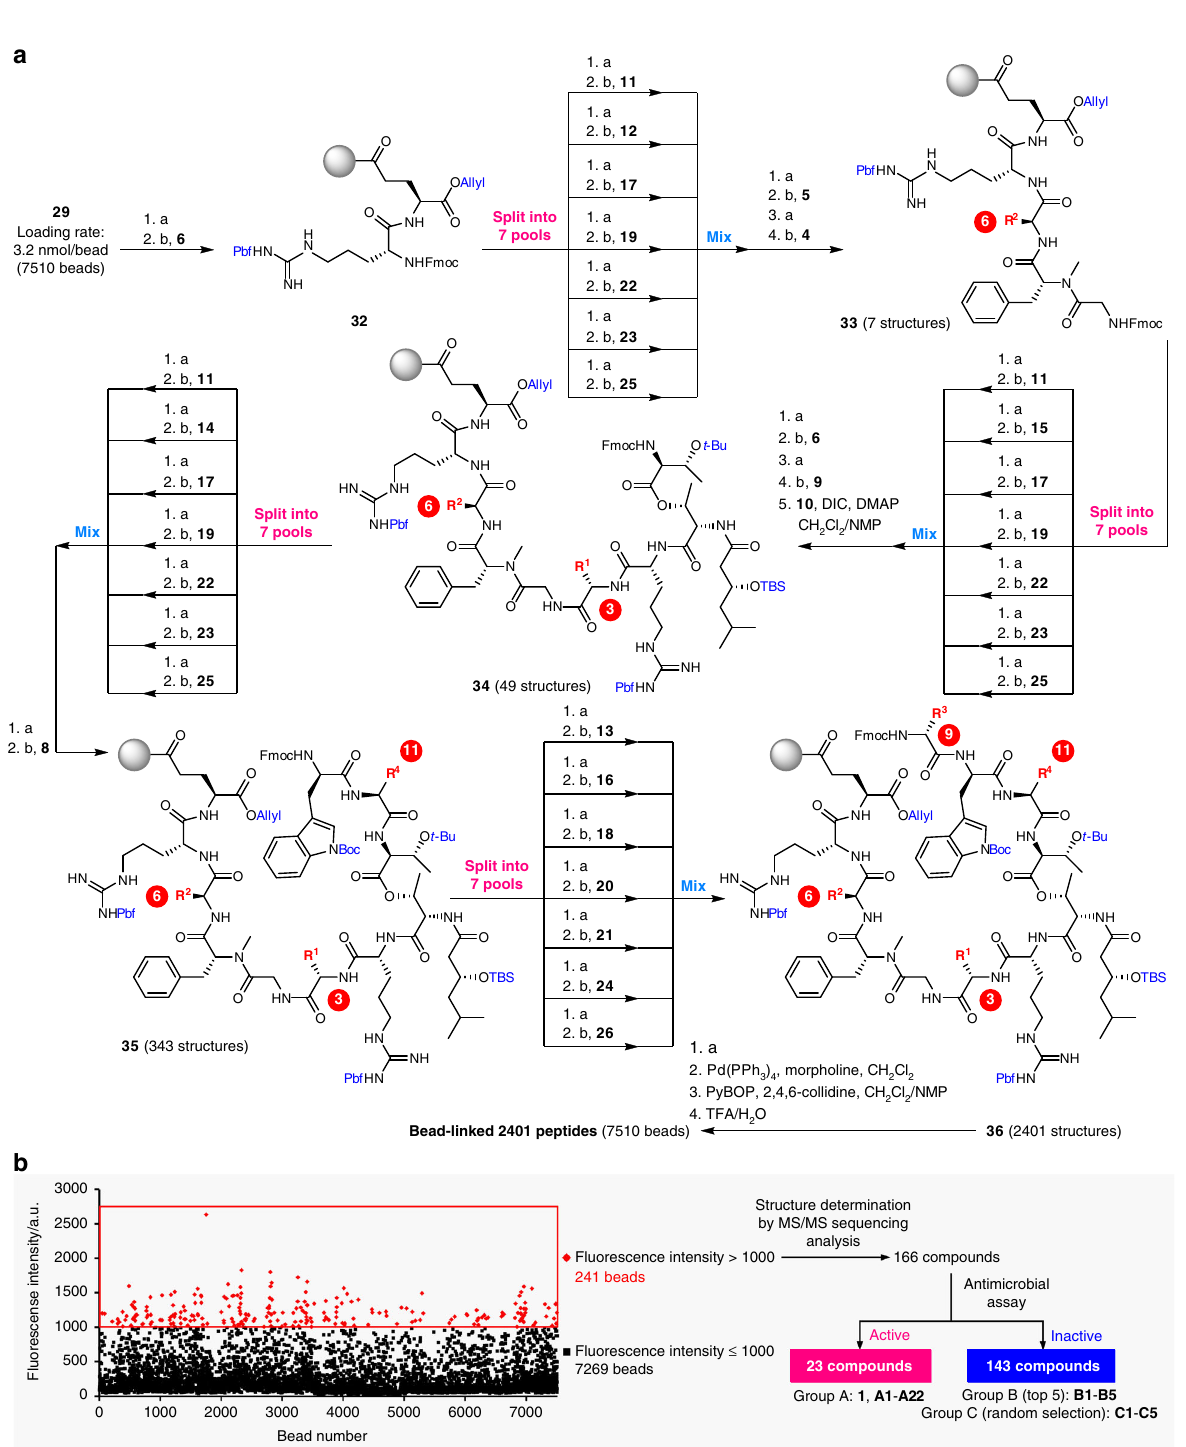
Fig. 4 Synthesis and screening of the OBOC library. a Synthesis of 1 -based OBOC library comprising 2401 bead-linked peptides. Reagents and conditions: a 20% piperidine/NMP, b HATU, HOAt, i -Pr 2 NEt, NMP, 40 °C (rt for 9 ). b Schematic diagram of selection of the compounds belonging to groups A – C. A dot plot of fl uorescence intensity against bead number (1 – 7510) in the 2 -complexation assay is also displayed. Fluorescence intensity corresponds to the relative amount of 2H . Beads exhibiting a fl uorescence intensity >1000 a.u. are plotted as red dots. Source data are provided as a Source Data fi